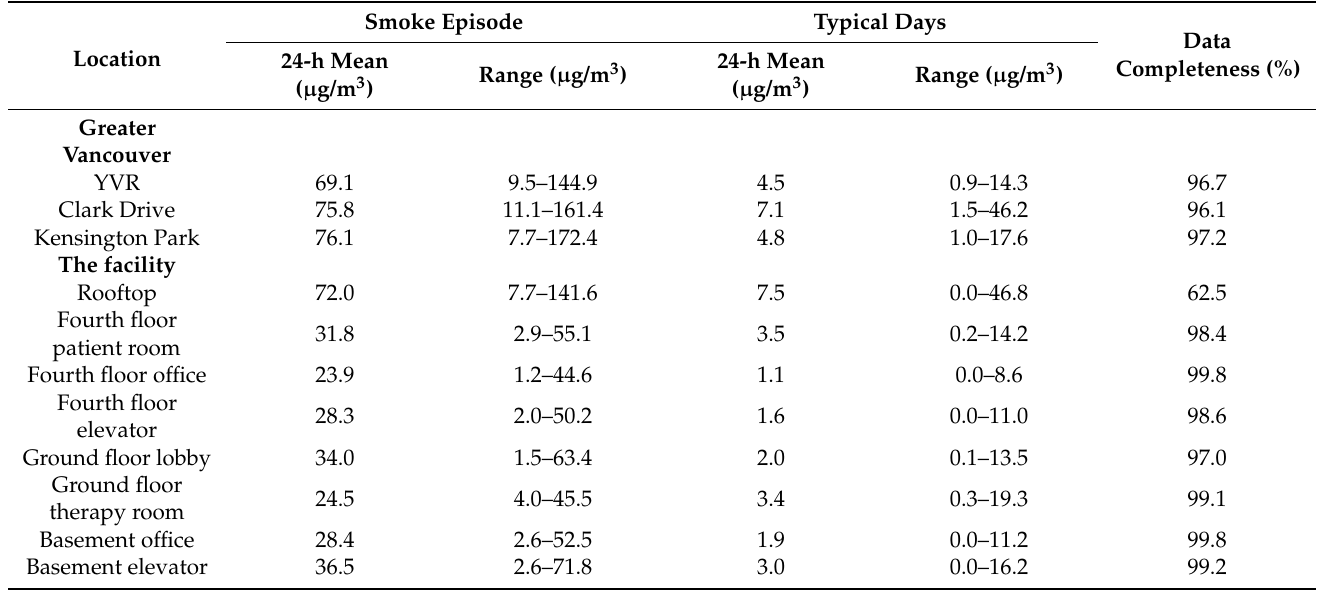
Table 3. The 24-h mean and range of PM 2.5 concentrations during the smoke episode and typical days. Vancouver International Airport (YVR), Clark Drive, and Kensington Park are ambient air quality monitoring stations in the National Air Pollution Surveillance (NAPS) network (Figure 2). At the rehabilitation facility, the rooftop sensor was outdoors while the other seven were indoors. Completeness of datasets is shown as percentages out of 103,680 expected 1-min data